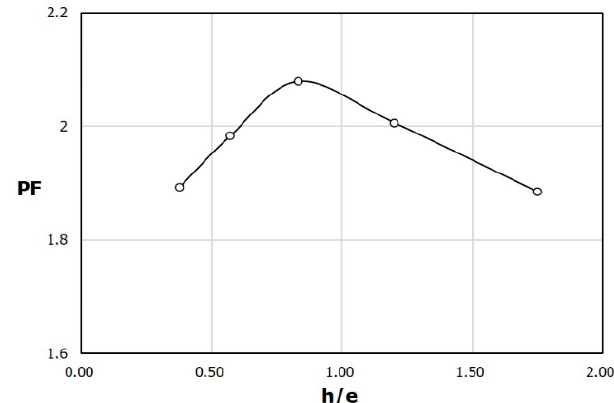
Figure 17. Variation of PF with h/e (rib area = 375 mm 2 ).